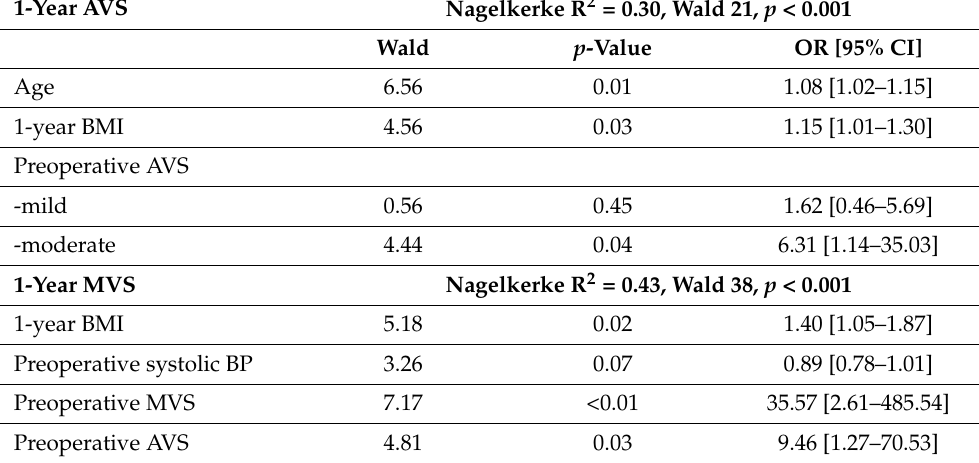
Table 3. Predictors of persistent valve sclerosis (AVS and MVS) 1 year after bariatric surgery identified in binary logistic regression analyses run with backward stepwise removal of non-significant variables. Excluded variables in both models: age; sex; preoperative diabetes, systolic and diastolic BP, BMI and pericardial fat; 1-year BP and pericardial